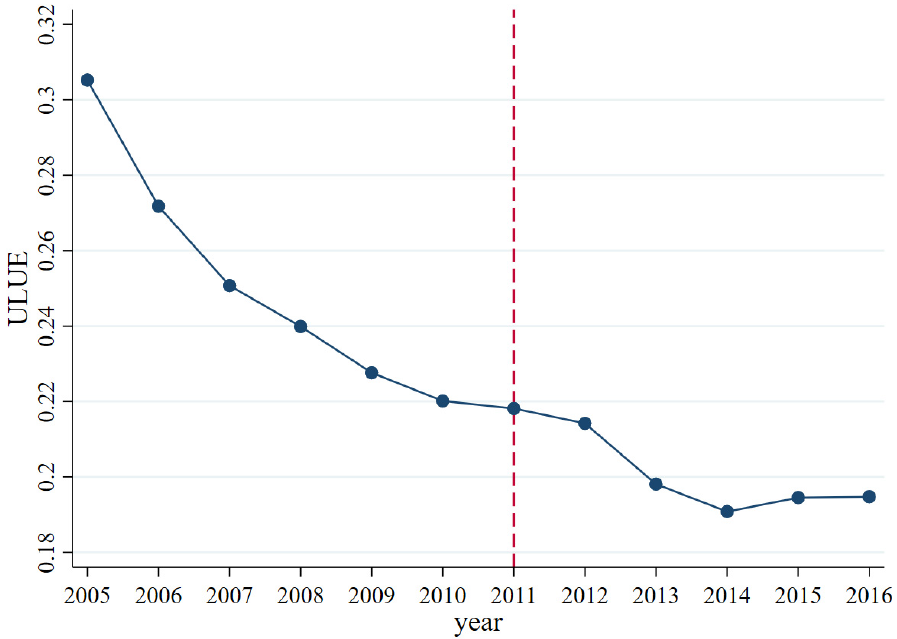
Figure 2. The time trend of the mean urban land use efficiency.